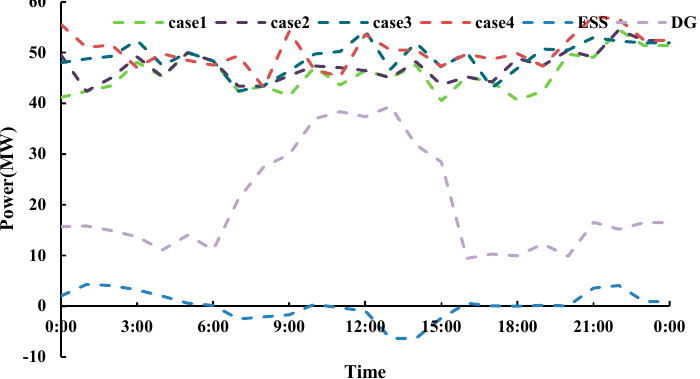
Figure 7. Accommodation capability for EVs by the distribution system under di ff erent cases and outputs from flexible resources.